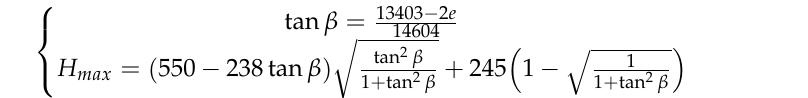
to point-surface